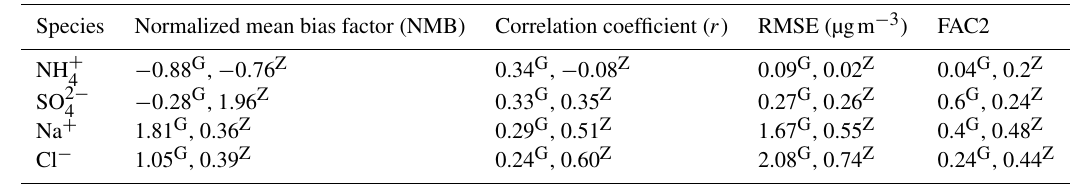
Table 2. Evaluation of modeled PM 10 values at both sites of Gruvebadet (G) and Zeppelin (Z) for the four particle-phase species Cl − , Na + , SO 2 − , and NH + . 4 4